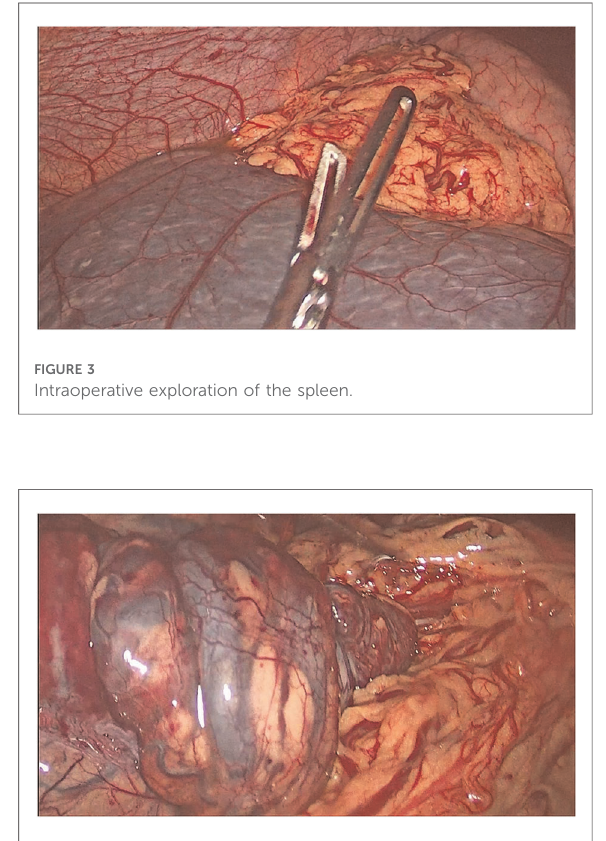
FIGURE 4 The twisted splenic